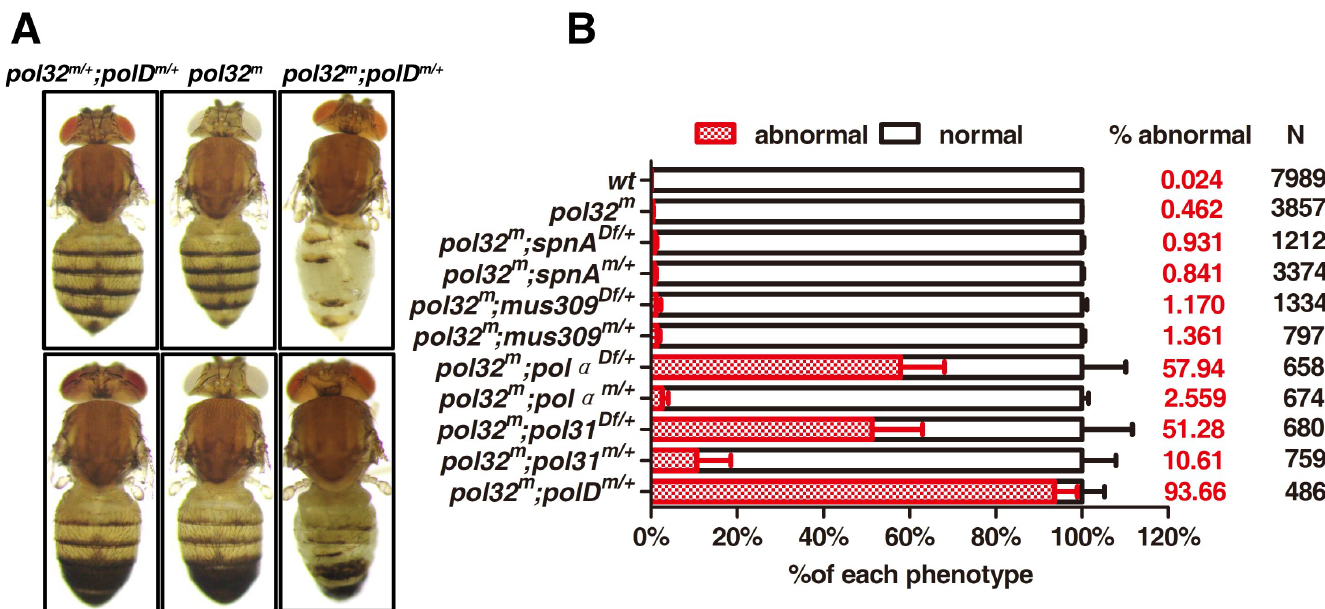
Fig 8. Genetic interactions between pol32 and other DNA replication and repair factors. A . Pictures of adult flies (three females at the top and three males at the bottom) showing etching of the abdominal region. Genotypes are given at the top. B . Quantification of the “etched abdomen” phenotype. The specific mutant alleles ( m ) are as followed: pol32 m = pol32 L27/L30 , spnA m = spnA 1 , spnA Df = Df(3R)X3F , mus309 m = mus309 D2 , mus309 Df = Df(3R)P-21 , pol α m = pol α G13925 , pold m = pold l10 , pol α Df = Df(3R)Exel6186 , pol31 m = pol31 G16501 , pol31 Df = Df(3L)Bsc122 .